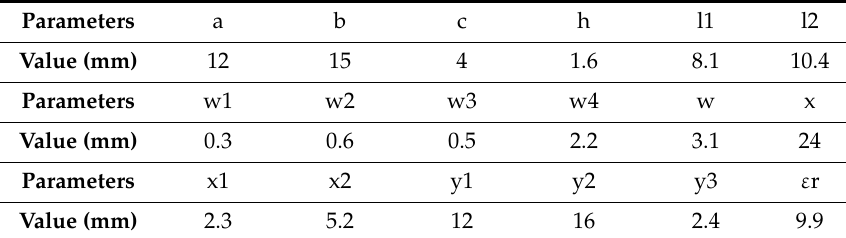
Figure 9. Prototype of the proposed DRA: (a) top view and (b) bottom view. Table 2. Final dimensions of the proposed antenna. Table 2. Final dimensions of the proposed antenna.